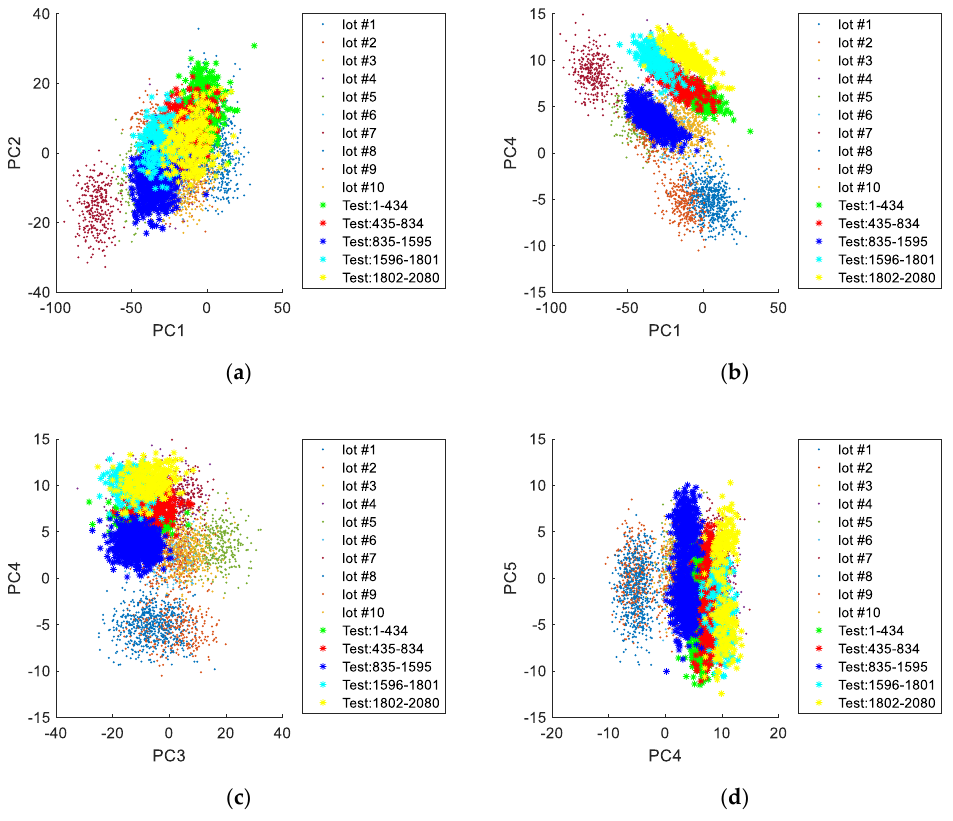
Figure 12. Relation between the principal components of the simulated validation lots and the data from CS2: ( a ) first and second principal components; ( b ) first and fourth principal components; ( c ) third and fourth principal components; ( d ) fourth and fifth principal components.